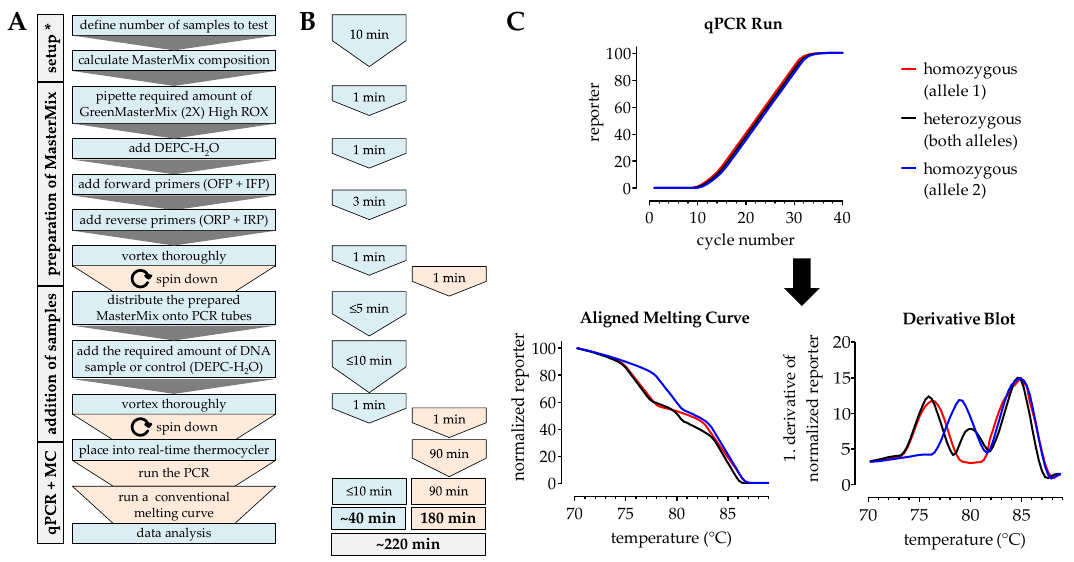
Figure 5. Workflow, timing, and expected results for the analysis of SNPs using the modified one-step ARMS-PCR method. In ( A ) workflow and ( B ) timing the blue color marks handling steps (time) of the experimenter and the orange color marks pause times caused by the procedure. ( C ) Expected results: While the PCR is running a fluorescent (SYBR green) signal should increase comparably between all samples. The following melting curve analysis (aligned melting curve and derivative blot) can be done without additional calculation steps. * When the method is frequently done a calculation matrix should be used.